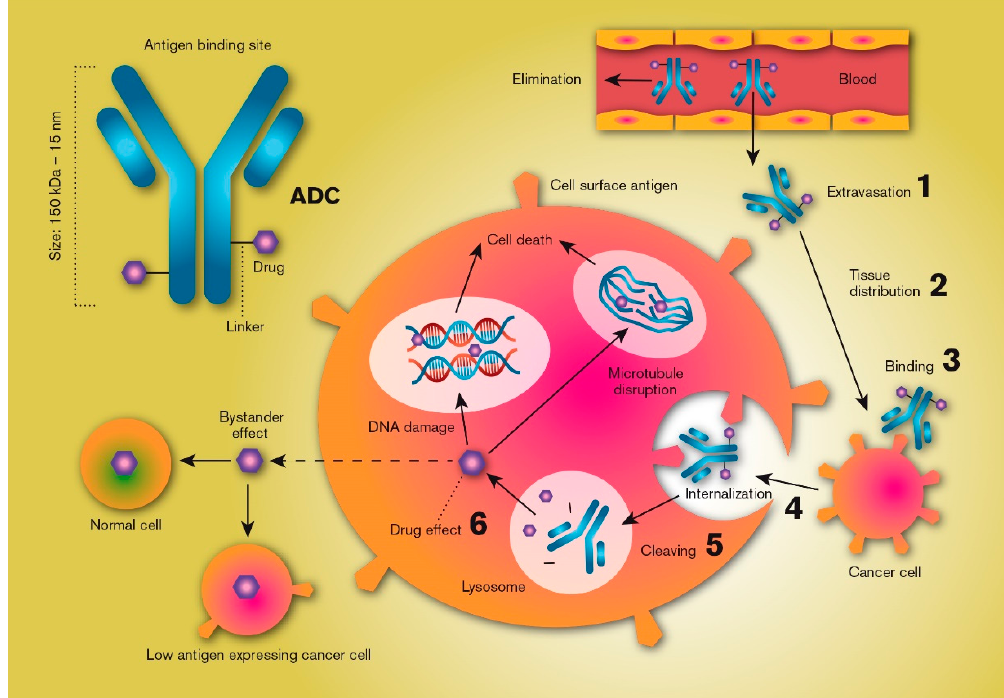
Figure 1. Schematic illustration of the key processes that determine the local distribution and effects of an antibody-drug conjugate (ADC). ADCs are products based on selective targeting, efficient internalization, and site-specific cleavage in the tumour cell resulting in the high intracellular availability of very potent chemotherapeutics. Critical features include plasma/systemic stability, tumour tissue diffusion/distribution, target selection, cell uptake characteristics, linker chemistry and cleaving mechanisms, and antibody-to-drug molecule ratio.